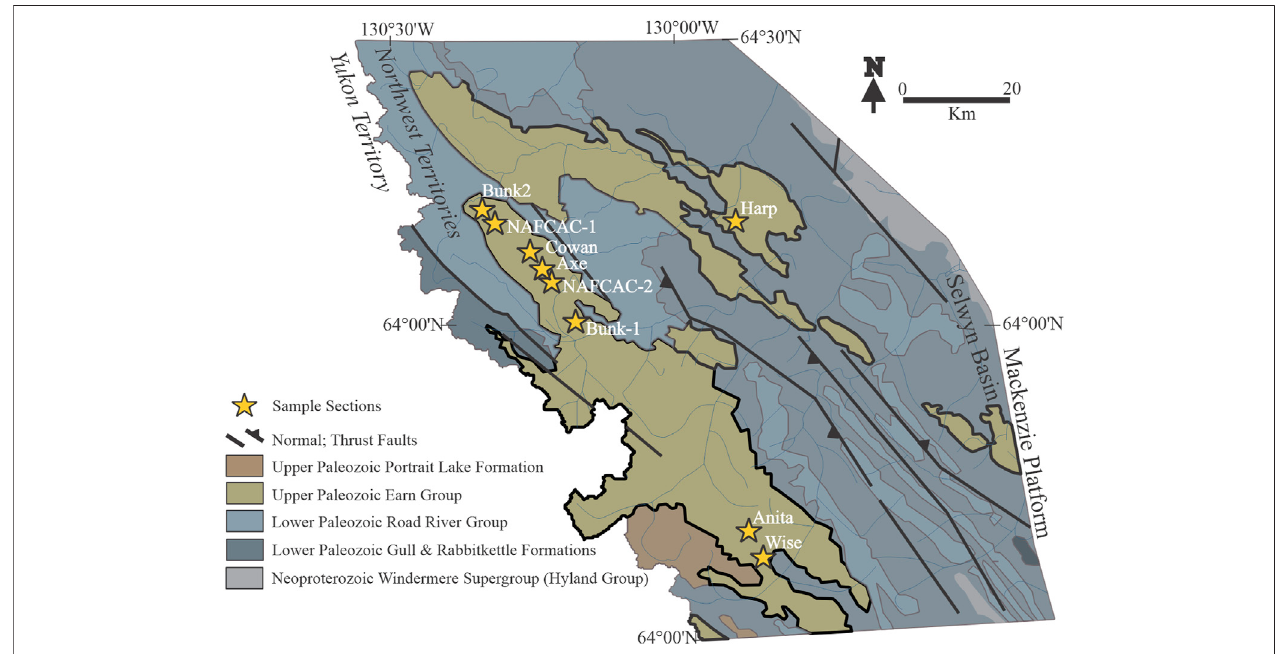
FIGURE 2 | Geologic map of the study area showing the sampled stratigraphic sections. (Modi fi ed from Ootes et al., 2013; Fernandes et al., 2017).